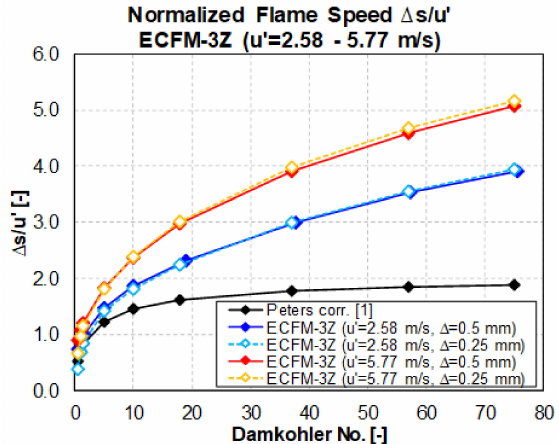
Figure 6. ∆ s / u (cid:48) CFD sensitivity to grid and time-step resolution for u (cid:48) = 2.58 m/s and u (cid:48) = 5.77 m/s for